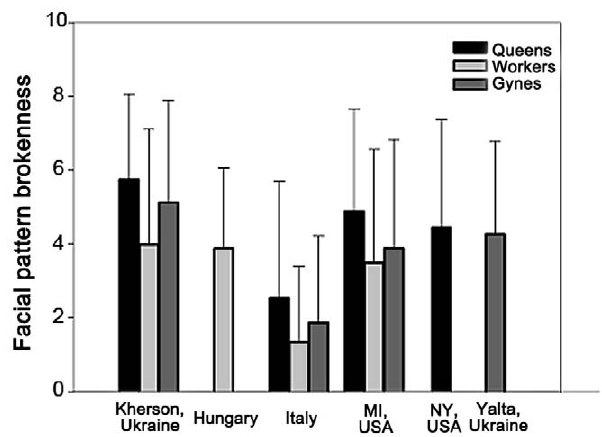
Figure 2. Mean ( ± SE) facial pattern brokenness of P.dominulus workers, gynes, and queens in six different populations.